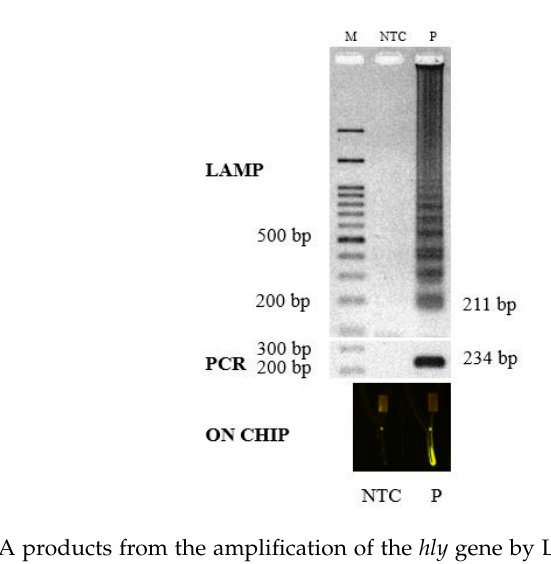
Figure 2. DNA products from the amplification of the hly gene by LAMP compared with the PCR products and with detection on a chip; Lane M, 100 base pair ladder; Lane ntc, non-template control; and Lane P, positive DNA from Listeria monocytogenes .